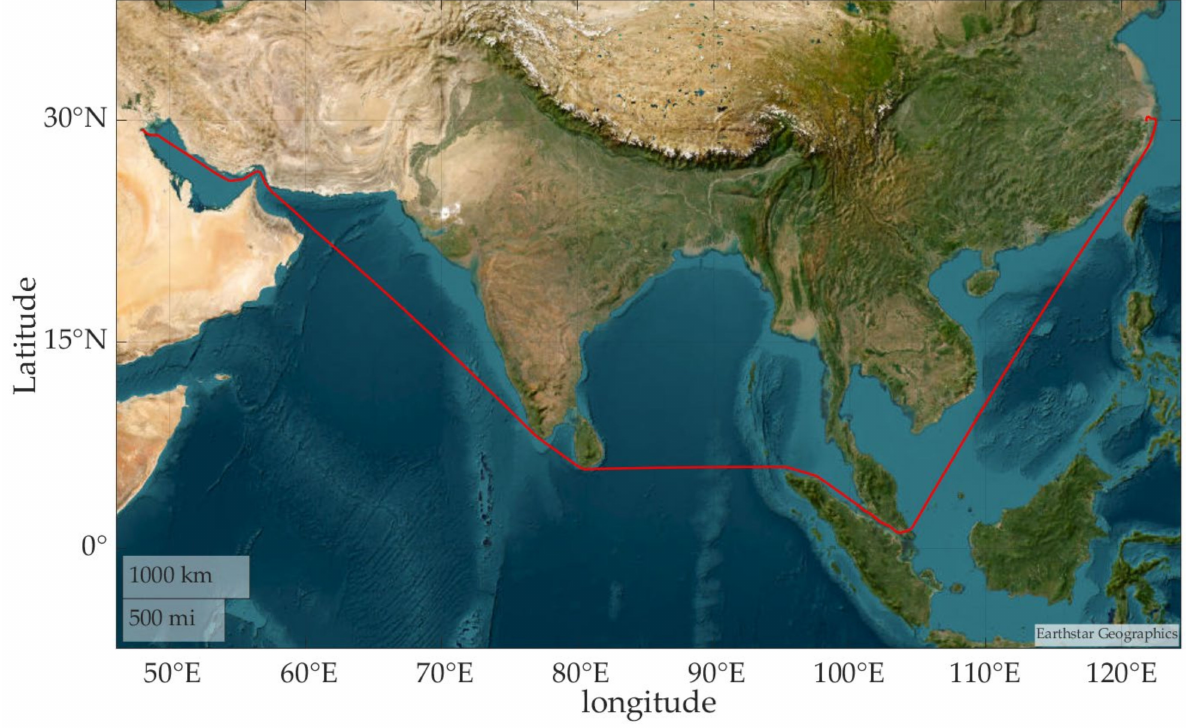
Figure 12. Target